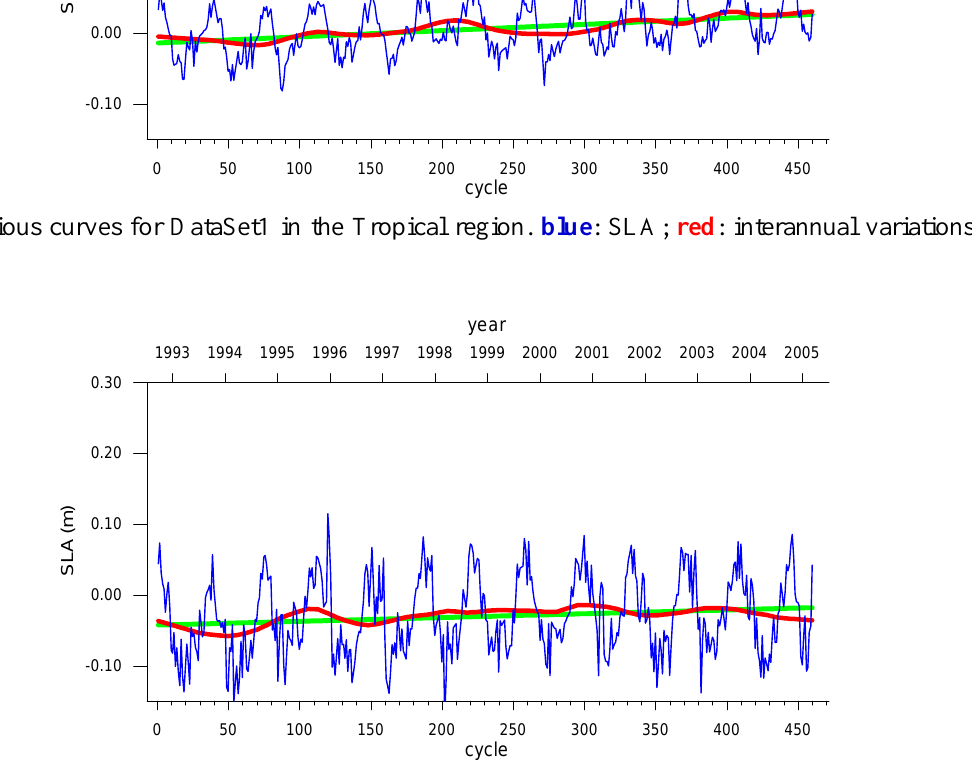
Figure 3b. Various curves for DataSet1 in the Sub-Tropical region. blue : SLA; red : interannual variations; green : linear